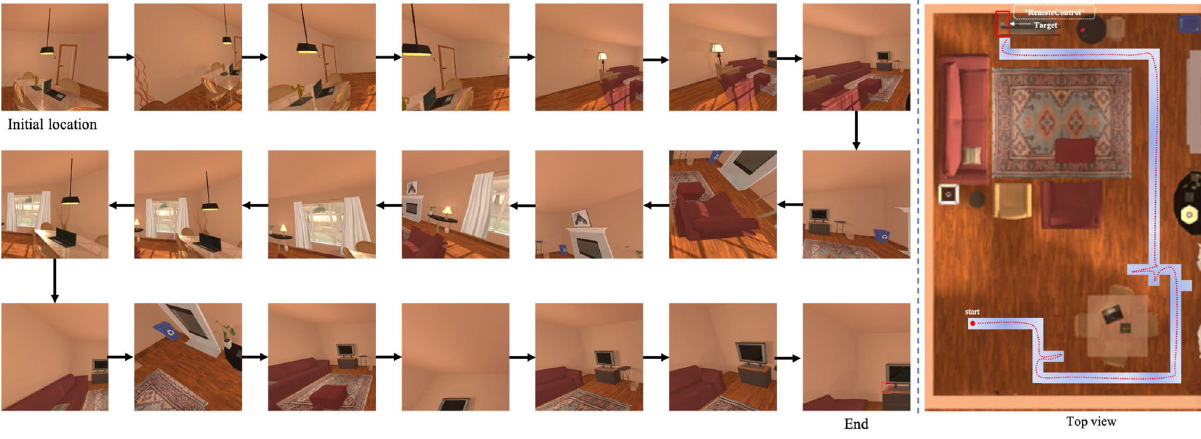
Fig. 5 Failure case. Figure showing an example trajectory of our model in living room from initial location to target. Because of the small size of the RemoteControl , the agent failed to find it when passing by. The agent goes back and forth around the table, but the target is not there (as shown in top